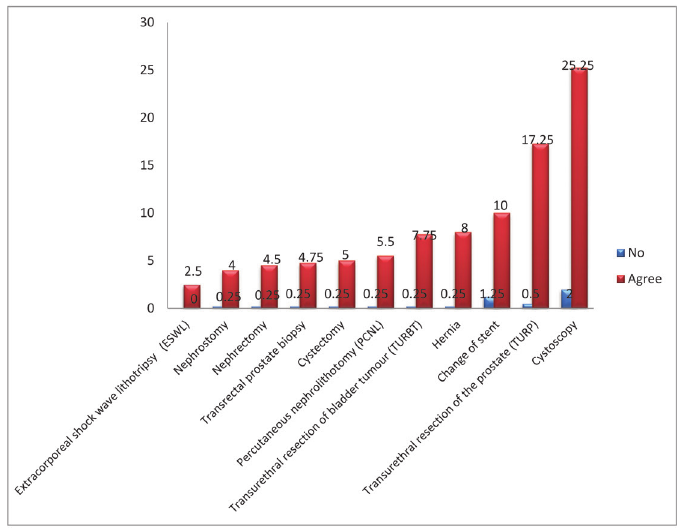
Figure 3. Discrepancy between the dose of antibiotic with the standard guideline.